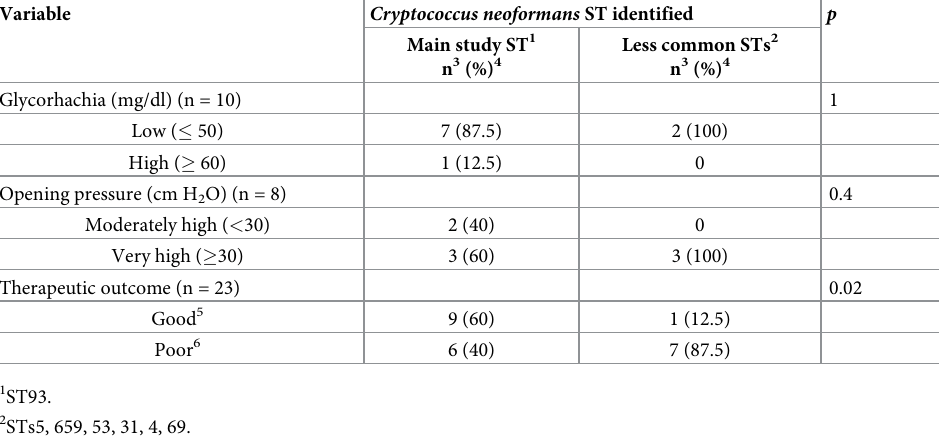
Table 4. NMC severity factors compared to the MLST STs of C . neoformans isolates.